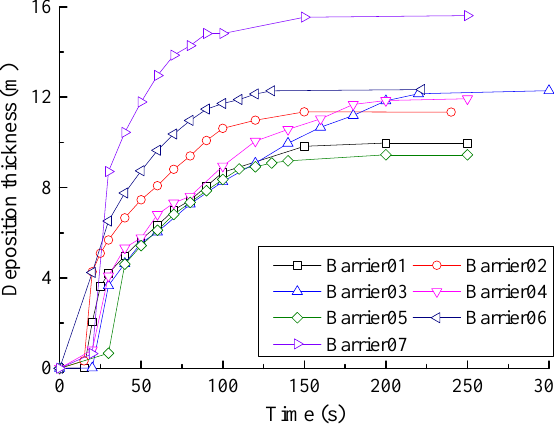
Figure 10. Deposition thickness at the front of the barrier.